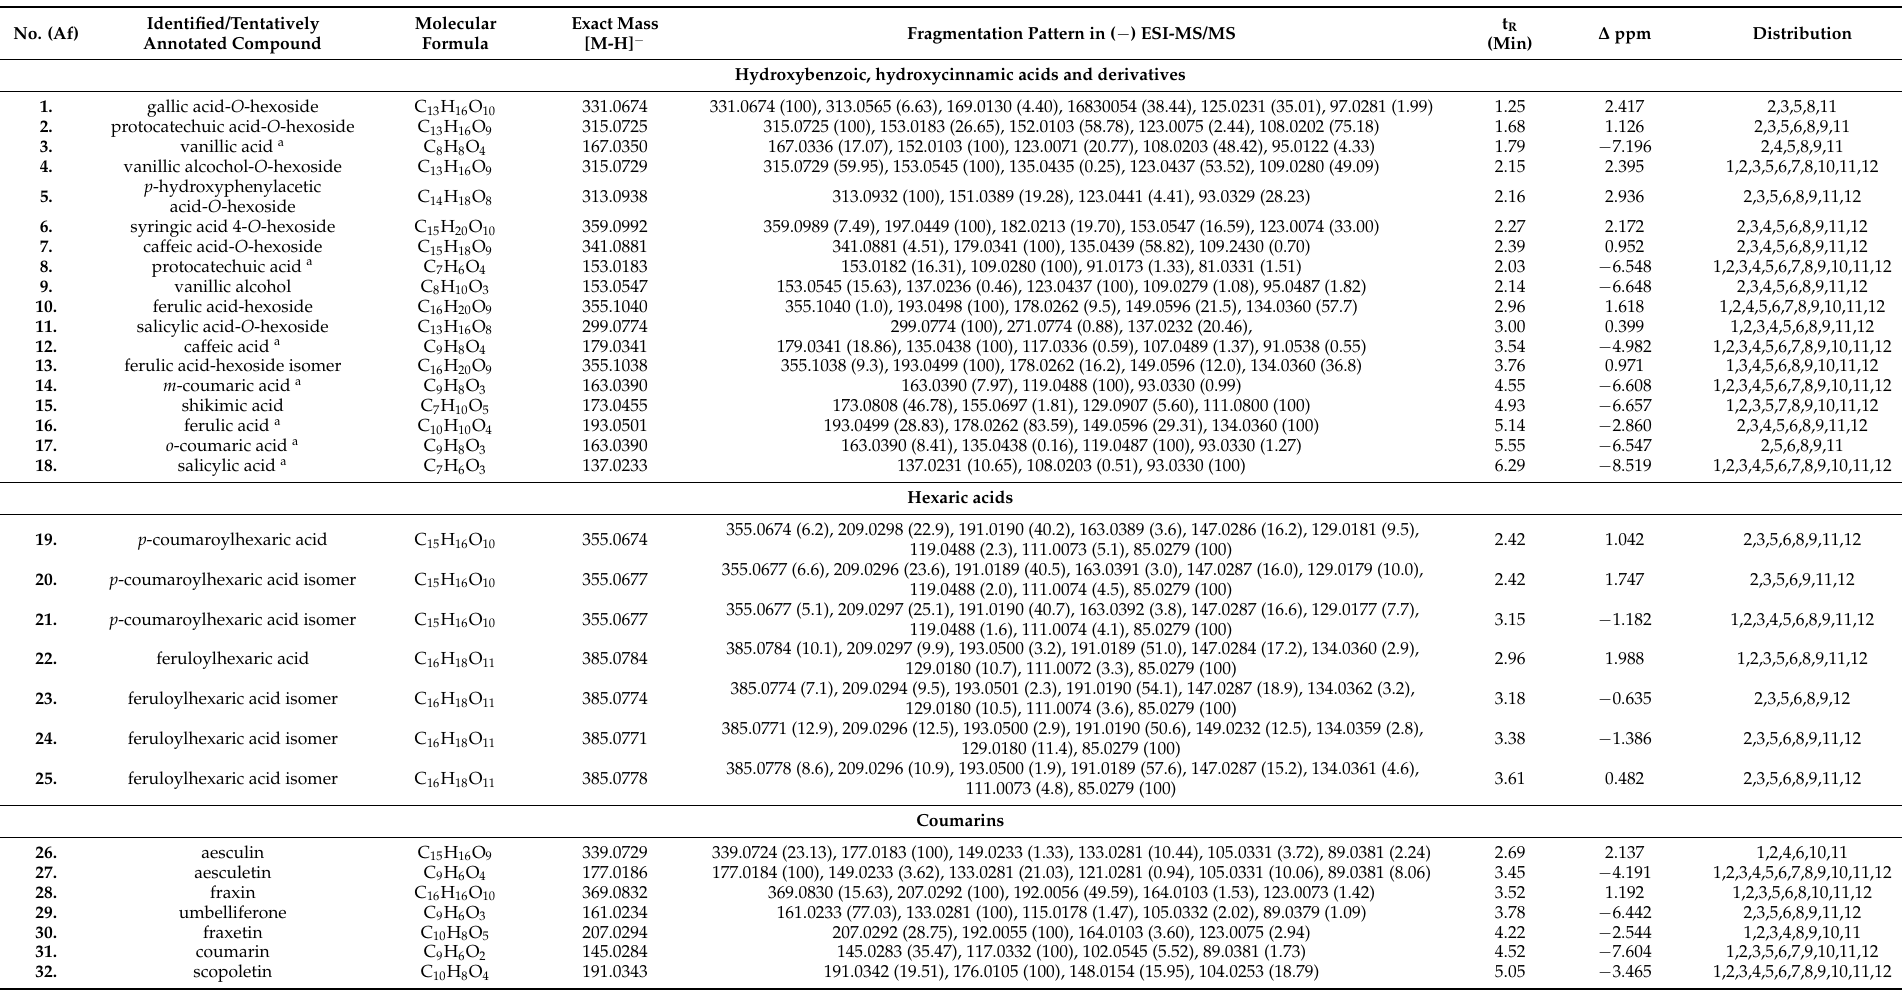
Table 2. Secondary metabolites in Alcea fasciculiflora extracts analysed by